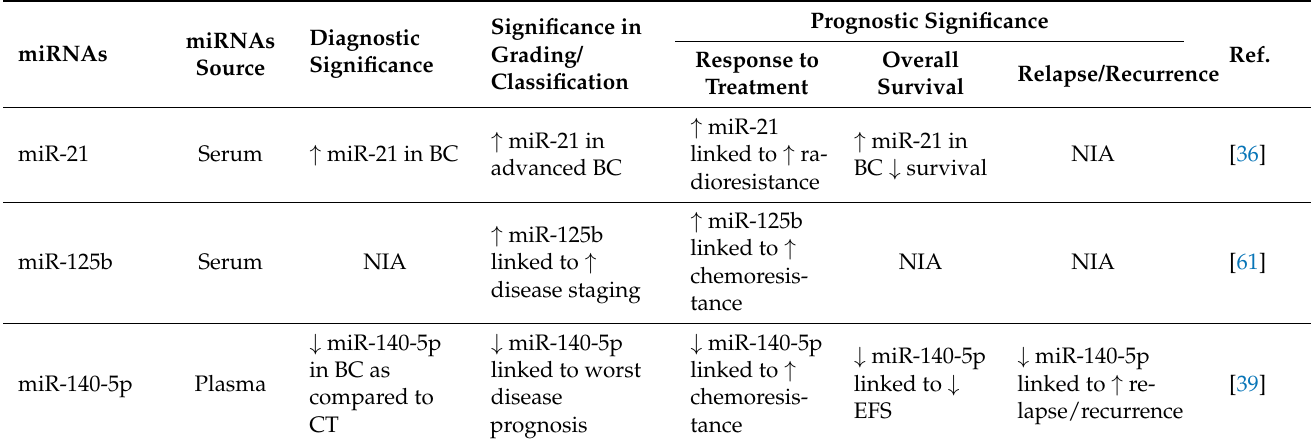
Table 3. Potential free-circulating miRNAs in diagnosing and predicting the prognosis or treatment responses among breast cancer patients. ↑ increase; ↓